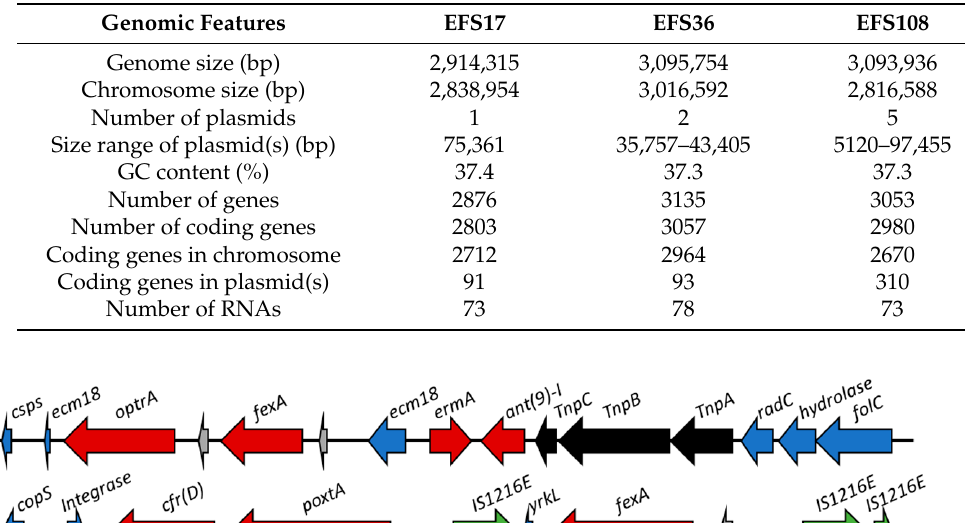
Table 4. Genomic features of three E. faecalis isolates.